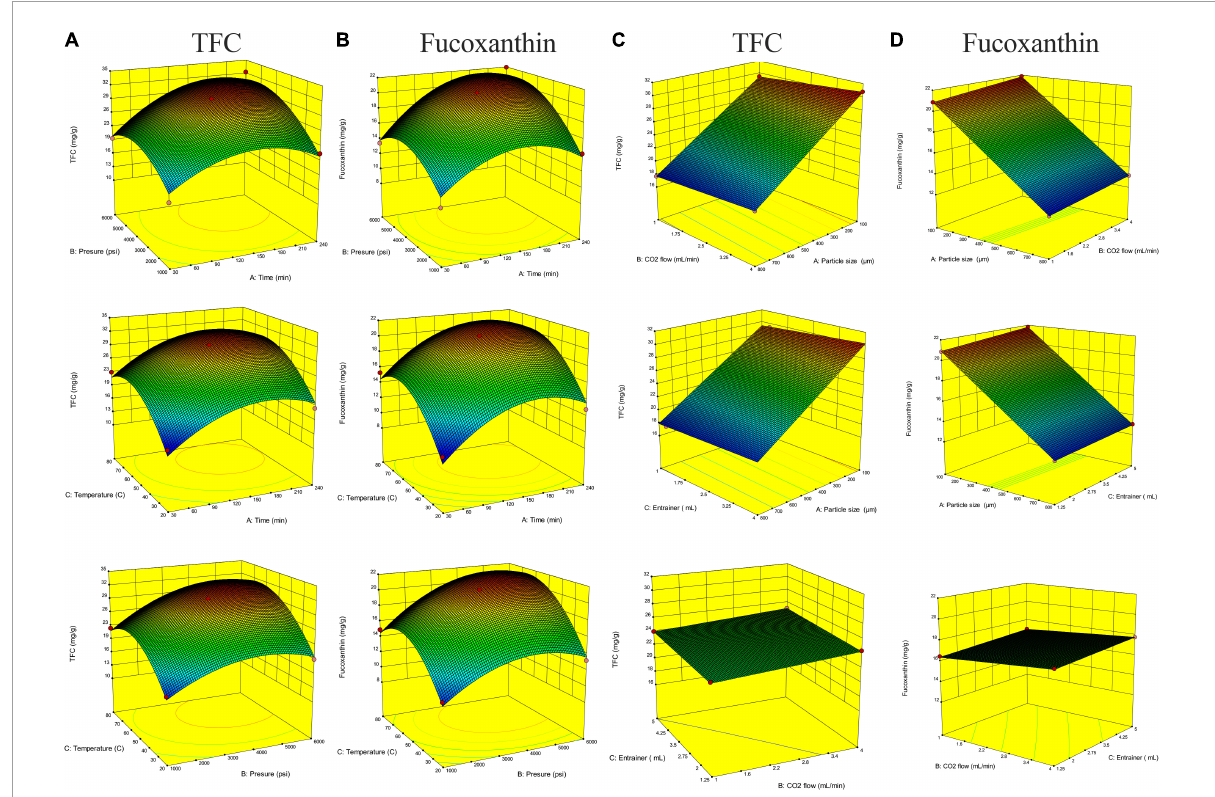
FIGURE2 Response surface plots of total flavonoid (TFC) and fucoxanthin content (mg/g) in the extract. (A,B) TFC and fucoxanthin versus the particle size (450 µ m), CO 2 flow (2.5 ml/min), and entrainer (1.25 ml). (C,D) TFC and fucoxanthin versus the extraction time (135 min), pressure (3500 psi), and temperature (50 ◦